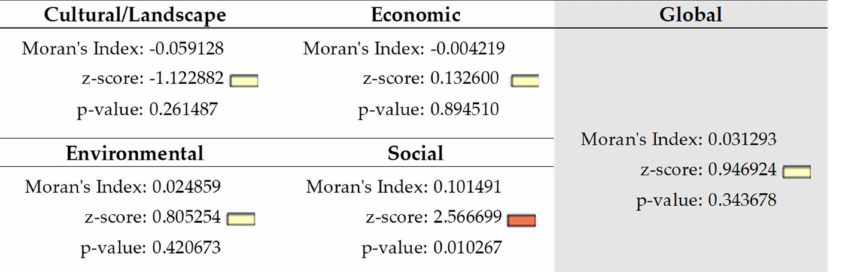
Figure 5. Moran’s global I results for the sustainability pillars. Source: authors’ own material from calculations carried out using ArcGIS